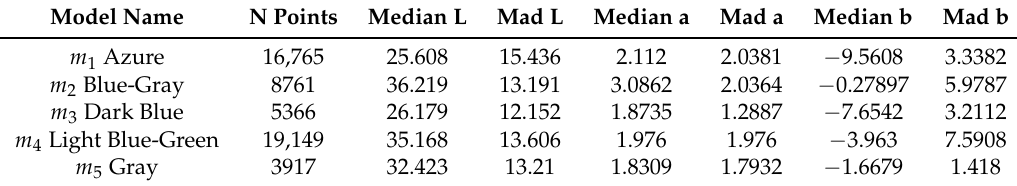
Figure 10. Examples of cropped images returned by the Otsu’s algorithm on the Taranto dataset (on the left) and the Azores one (on the right). Table 2. Fin color sets specification.